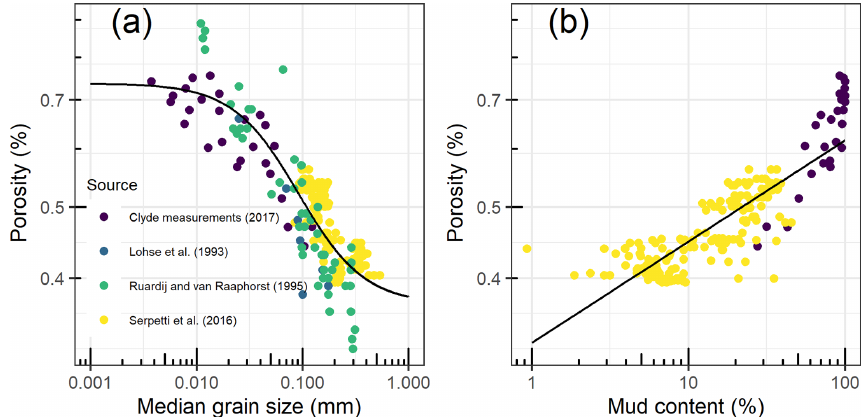
Figure 12. Relationship between sediment porosity (%) and (a) median grain size (mm) and (b) percentage of mud content for measurements for the top 10cm seabed sediment on a log 10